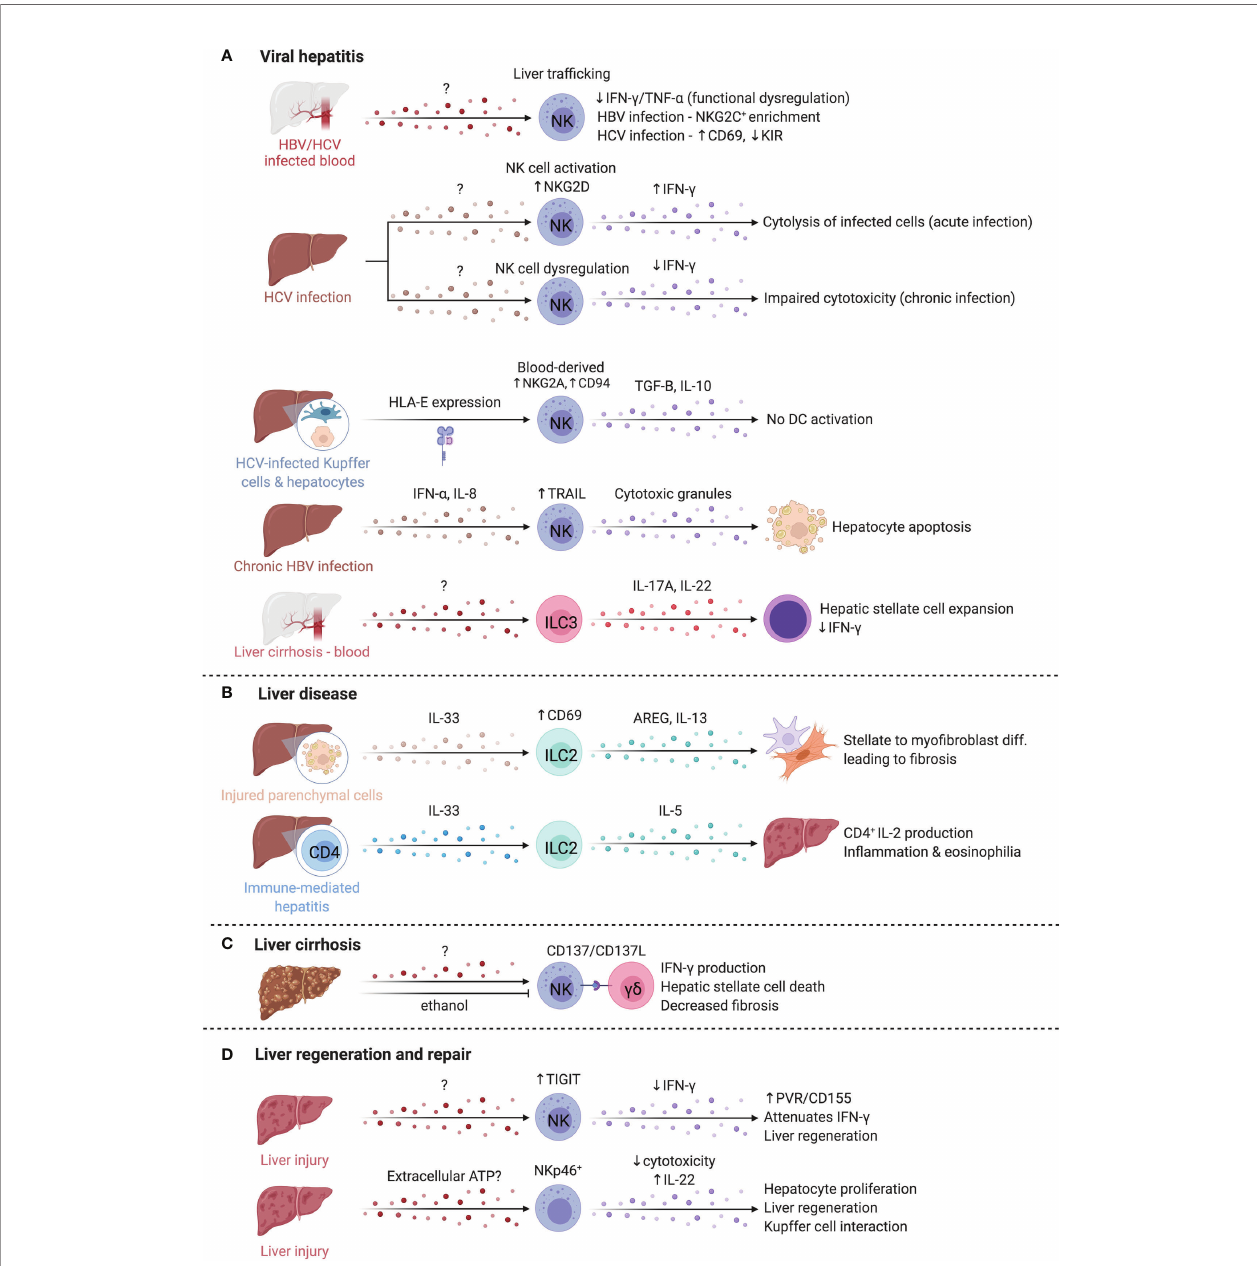
FIGURE 7 | ILCs in the liver. The liver is occupied by a variety of ILCs that play diverse roles in viral hepatitis, liver disease, liver cirrhosis, and liver regeneration and repair. (A) Hepatitis C (HCV) and Hepatitis B (HBV) are key inducers of liver in fl ammation and cirrhosis and lead to the development of hepatocellular carcinoma. The abundance of NK cells in the blood of both HBV/HCV infected patients is reduced, suggesting elevated homing to the liver where functional de fi ciencies like impaired IFN- g and TNF- a production are reported. NK cells in chronic HBV and HCV infected patients adopt distinct phenotypes that manifest in an enrichment of NKG2C- expressing NK cells or altered CD69 and inhibitory KIR expression. In contrast, acute HCV infection promotes elevated NKG2D and IFN- g expression while IFN- g is reduced in chronic infections. HCV-infected hepatocytes and Kupffer cells express higher levels of HLA-E that boost TGF-B and IL-10 production by NK cells through NKG2A and CD94. CD56 bright NK cells in chronic HBV infection facilitate TRAIL-dependent hepatocyte death. ILC3s separately support hepatic stellate expansion and counteract IFN- g . (B) In liver disease, ILC2s are increased and activated, driving liver fi brosis via AREG and IL-13. Similarly, in immune-mediated hepatitis, ILC2s were expanded and produced high levels of IL-5, recruiting eosinophils, and driving in fl ammation. (C) In liver cirrhosis, crosstalk between NK cells and gd T cells through the CD137-CD137L axis enhanced cytotoxicity of NK cells against HSCs. Alcohol exacerbates fi brosis chronically, but also attenuates NK- mediated cell killing, and reduced NKG2D, TRAIL and IFN- g expression on NK cells. (D) NK cells upregulate TIGIT while hepatocytes upregulated the ligand PVR/ CD155, attenuating IFN- g production and promoting liver regeneration. Finally, extracellular ATP is elevated after liver injury and regulates regeneration in the liver via NKp46 + NK cells. Created with